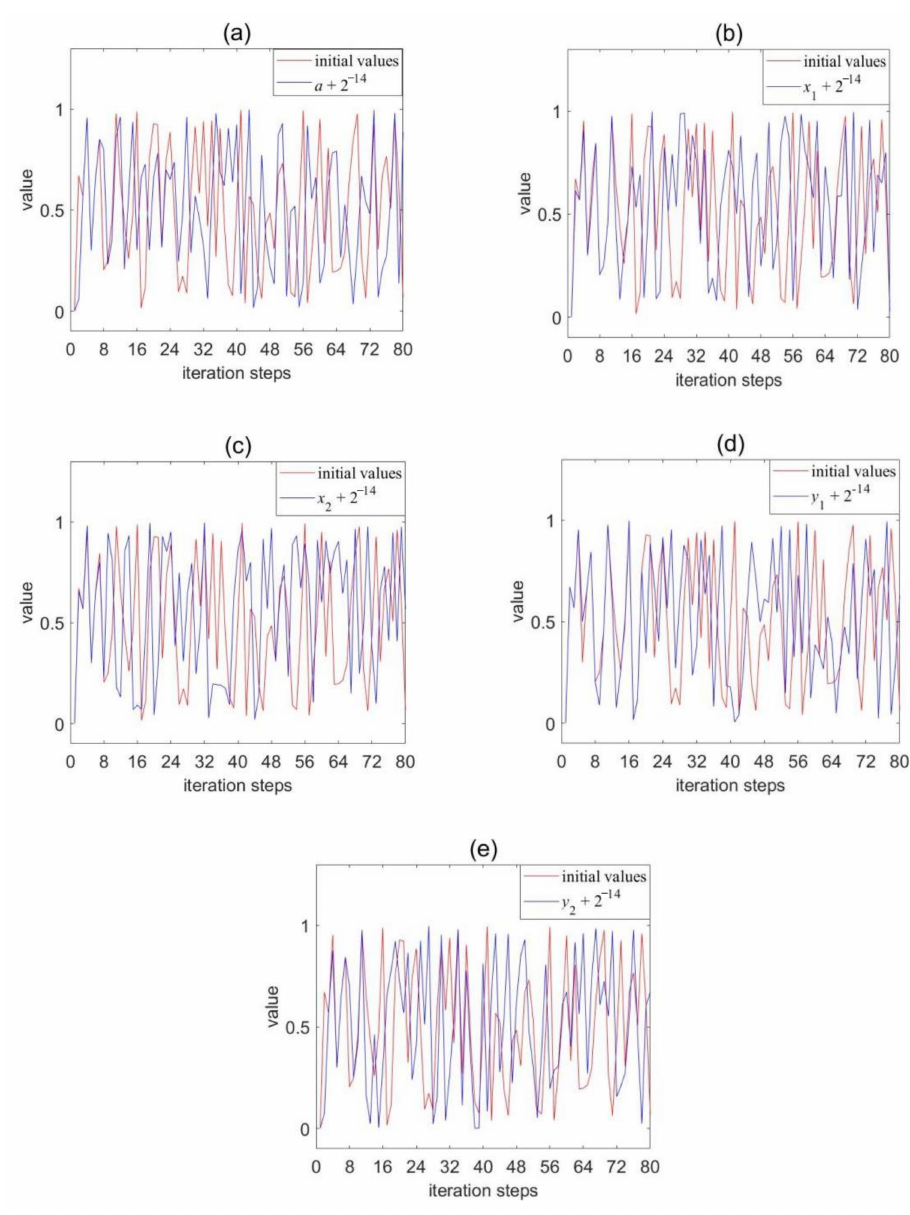
Figure 8. Sensitivity analysis: ( a ) The key change is a + 2 − 14 ( b ) The key change is x 1 + 2 − 14 ( c ) The key change is x 2 + 2 − 14 ( d ) The key change is y 1 + 2 − 14 ( e ) The key change is y 2 + 2 − 14